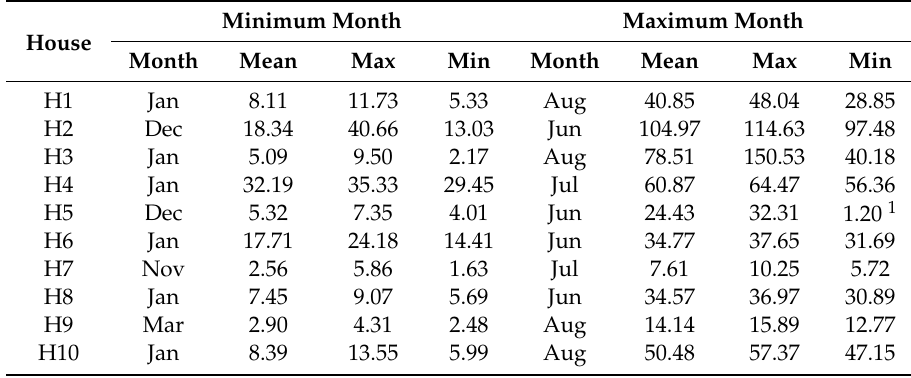
Table 5. Daily electricity consumption per capita (kWh / ca)